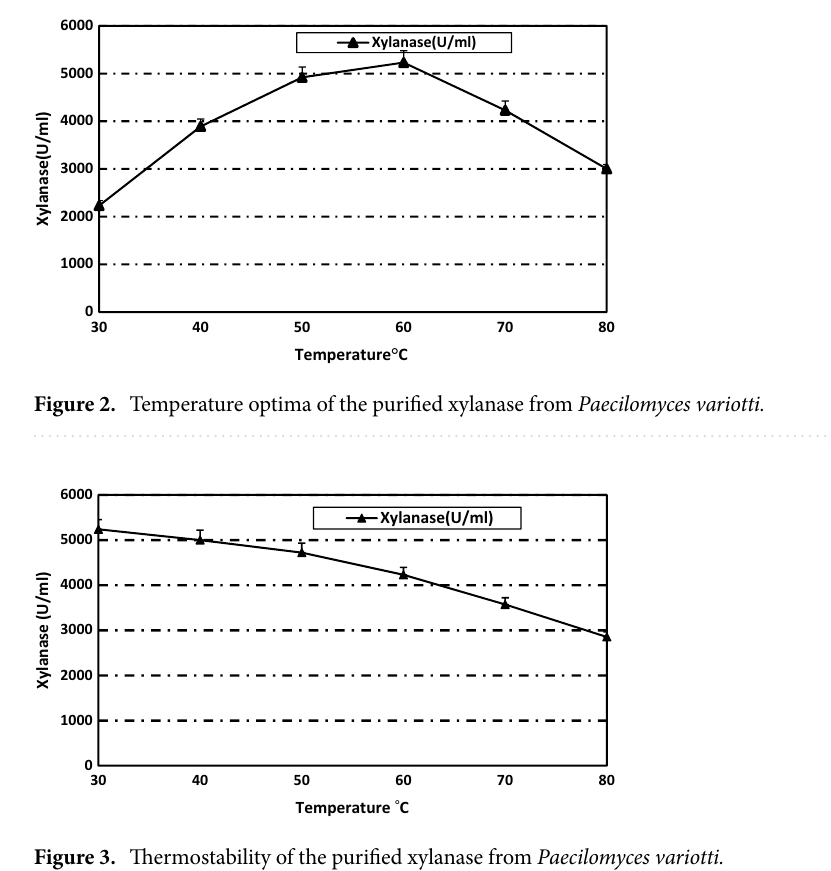
Figure 3. Thermostability of the purified xylanase from Paecilomyces variotti.